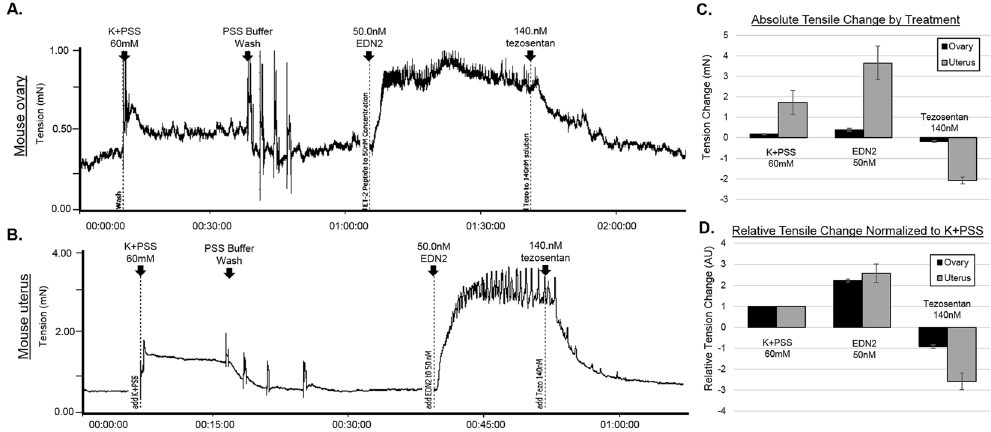
Figure 6. EDN2 induces contraction in mouse ovaries and uteri in an Endothelin receptor-dependent manner. WT mice were superovulated and ovaries (n = 8) were collected at hCG12–16 hours and were placed in a myograph machine for tension analysis. ( A ) A representative control ovary response to a 60 mM K + PSS solution (for normalization), a 50 nM EDN2 solution, and a 140 nM tezosentan solution to block Endothelin receptors. This treatment schema was similarly used to measure responses in ( B ) WT uteri (n = 5). Vertical axis: tension in millinewtons where 9.81 mN = 1.00 gram-force. Horizontal axis: Time (Hours:Minutes:Seconds). ( C ) Comparison of absolute tension changes between tissues in response to Endothelin receptor agonization and subsequent antagonization. ( D ) Ovarian and uterine contraction normalized to the response to K + PSS to compare relative contractile responses. Error bars represent the